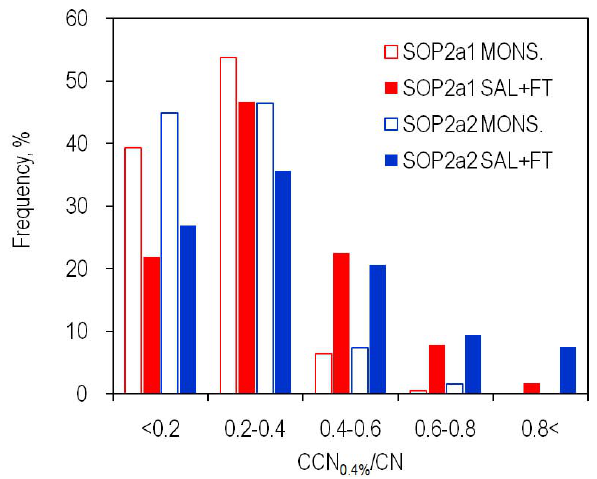
Fig. 6. Frequency distribution of various CCN/CN ratios (at 0.4% super saturation) measured in different wind regimes (SAL + free troposphere vs. Monsoon layer) during SOP2a1 (monsoon onset pe- riod) and SOP2a2 (high monsoon